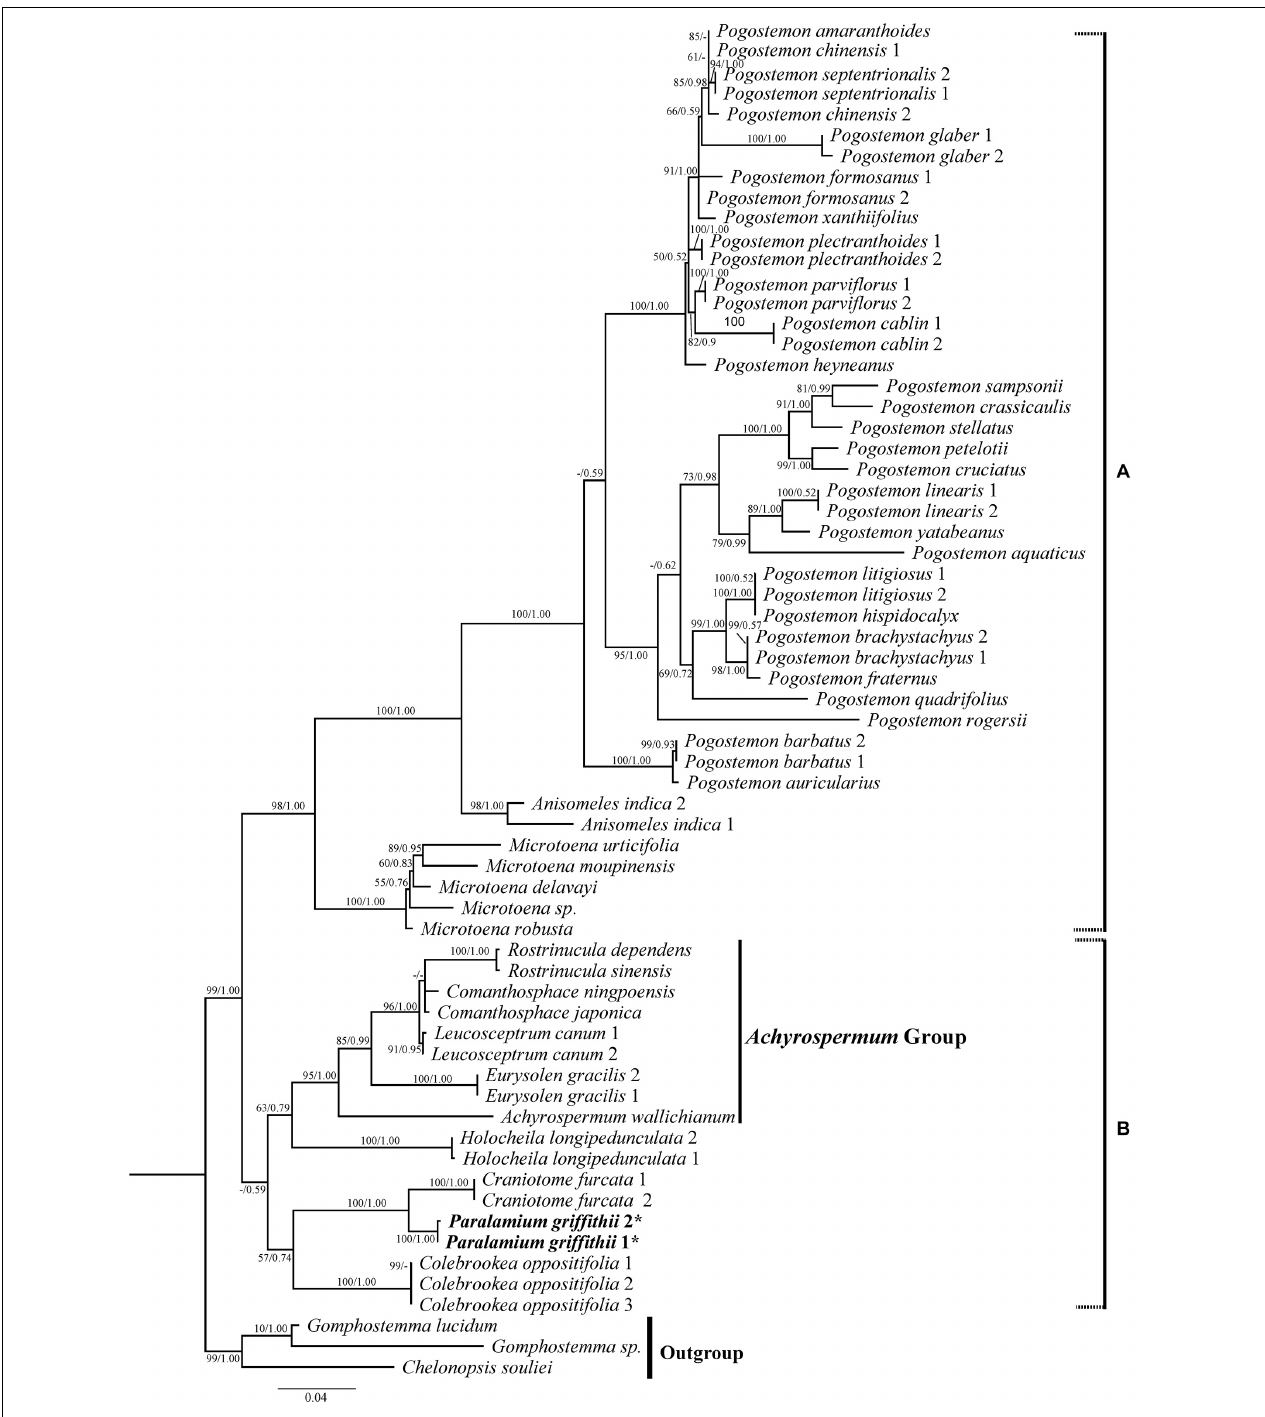
FIGURE 3 | Phylogenetic relationships of Pogostemoneae based on the nrITS dataset. The support values (BS/PP) are indicated above branches. BS values < 50% and PP support < 90% indicated by -. The outgroup and other major groups are labeled at the right.